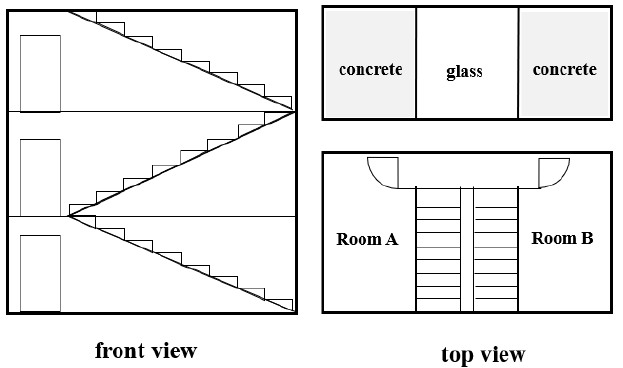
Figure 8. The internal structure of “Tongtian house”. In this structure, the only path to go up and down is the staircase in the middle that leads to the top.